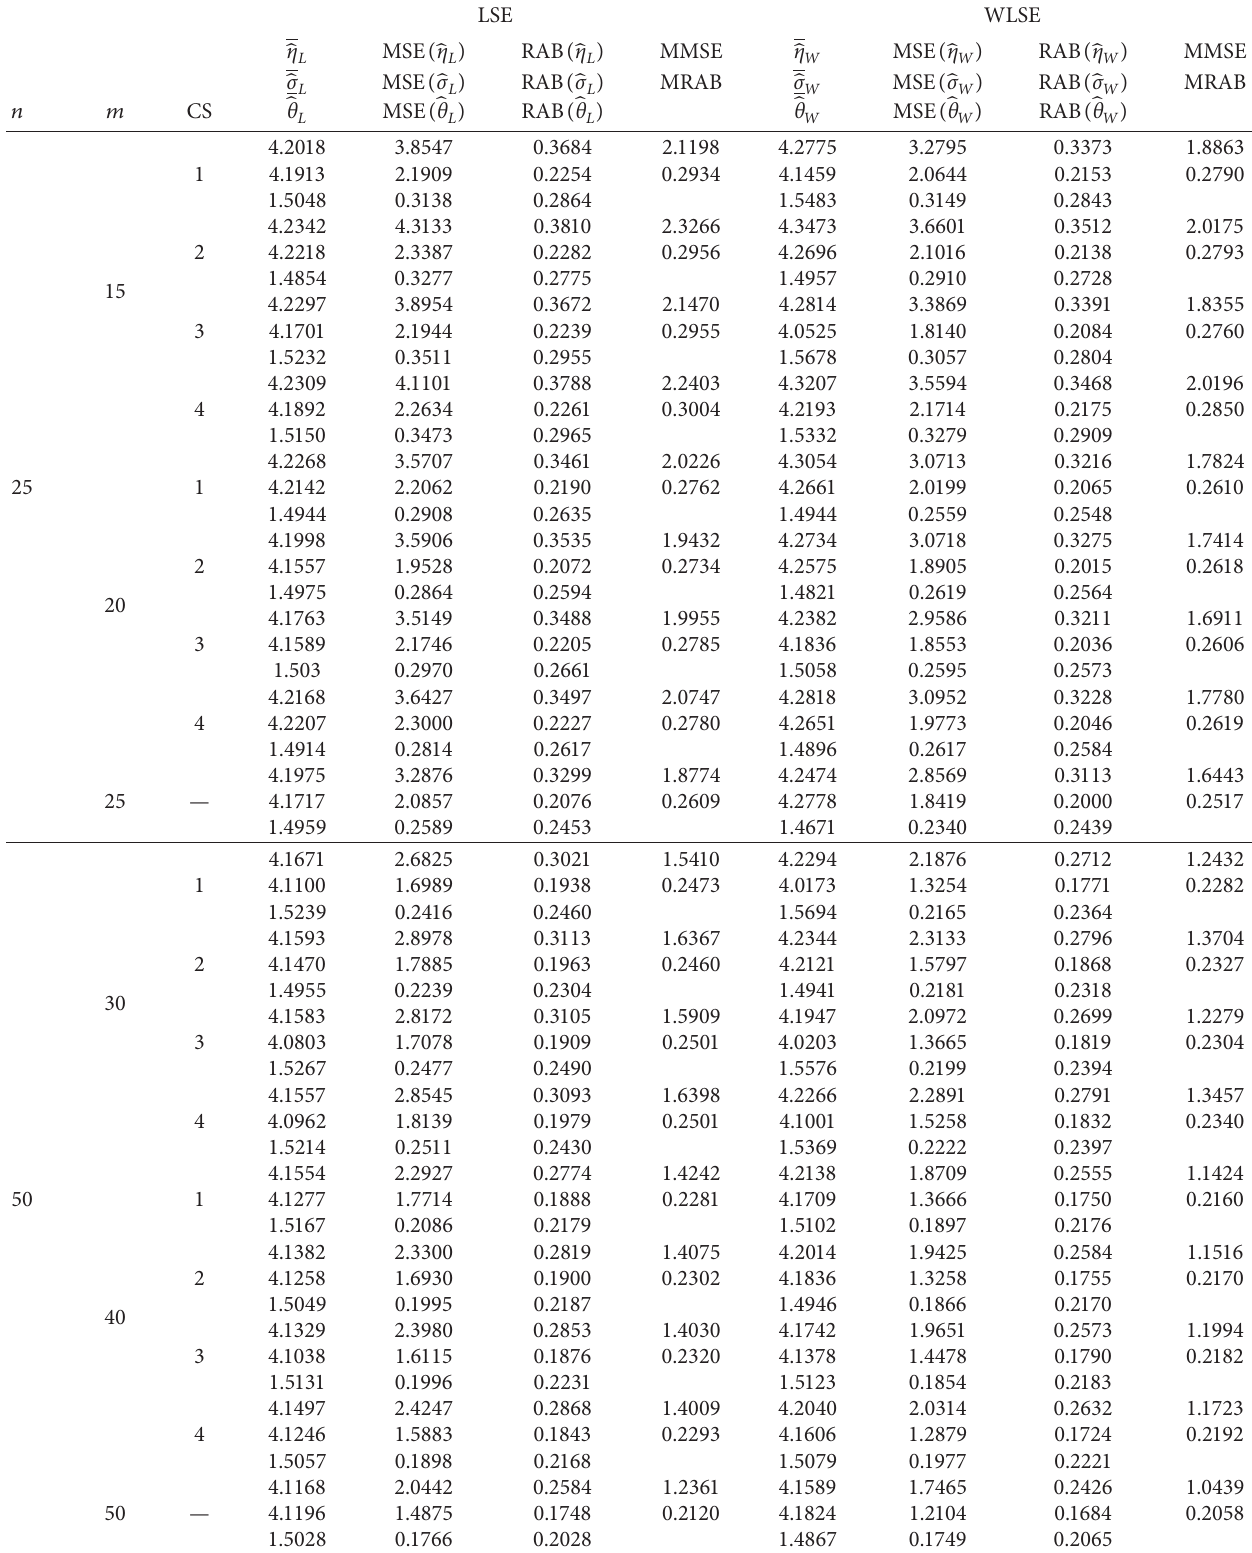
Table 5: LS and WLS estimates of η , σ , and θ with their MSEs, RABs, MMSE, and MRAB based on 5 , 000 simulations. Population parameter values are η � 4 . 0, σ � 4 . 0, and θ � 1 .